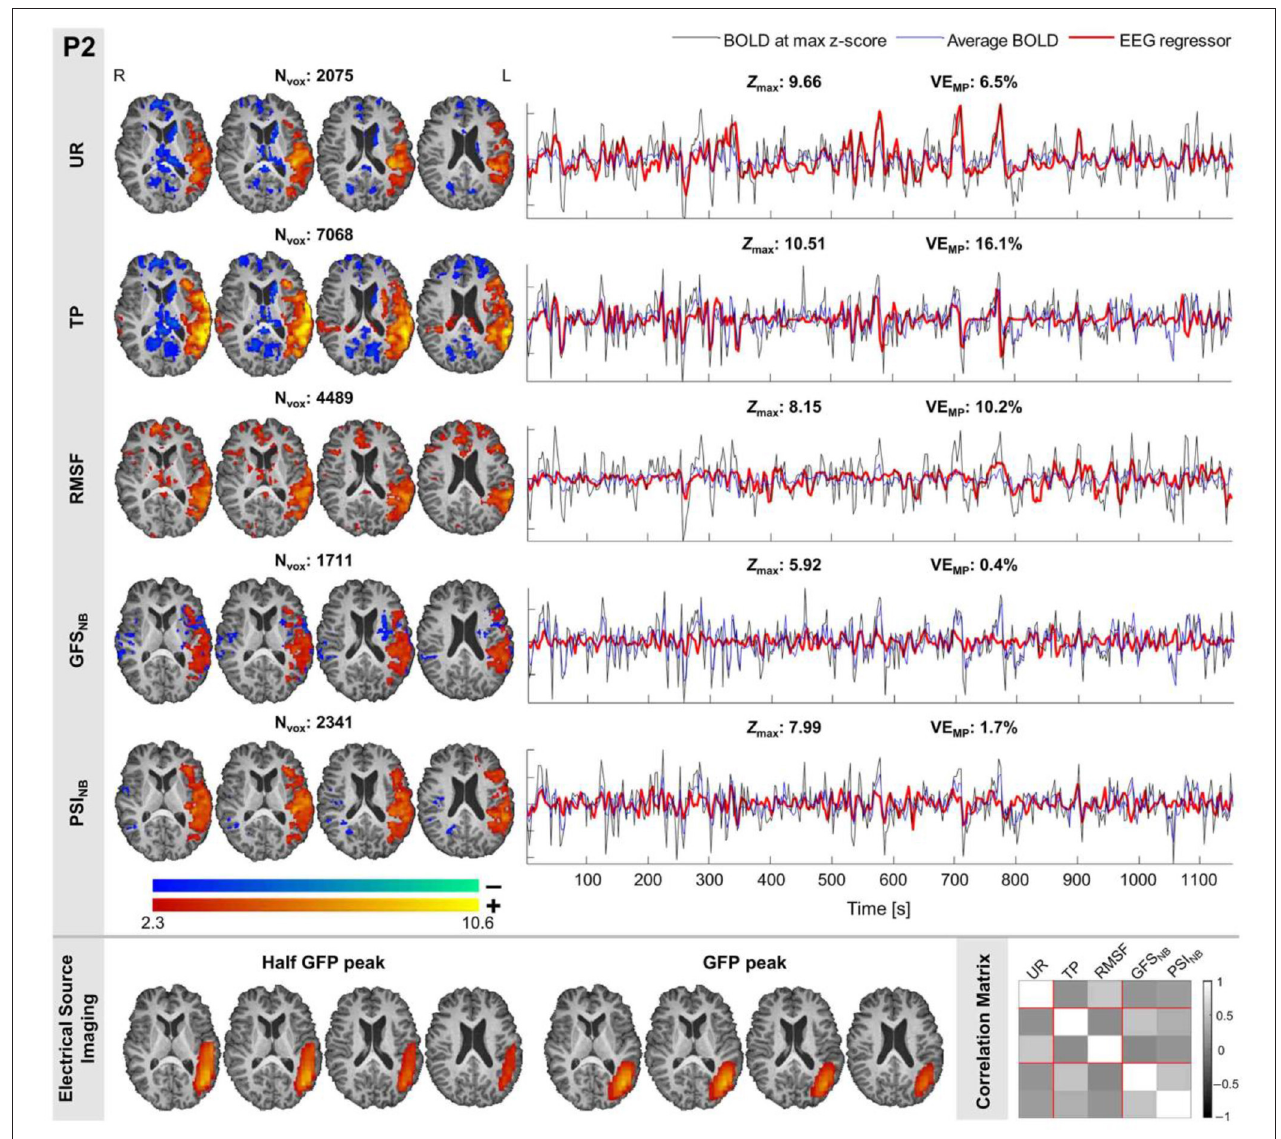
FIGURE 14 | The results of epileptic network mapping for a patient. (Top–Left) The epileptic networks obtained using the EEG regressors UR, TP, RMSF, GSF NB , and PSI NB , together with the number of voxels (Nvox); the color codes red-yellow and blue-green depict positive and negative BOLD responses, respectively. (Top–Right) The BOLD signal measured at the maximum Z-score voxel (black trace), the average BOLD signal within the activation cluster (blue trace), and EEG regressor (thicker red trace), together with the maximum Z-score (Zmax) and the variance explained by the motion parameters (VEMP). (Bottom–Left) ESI solution maps at IED onset and propagation, obtained at half the maximum of the first rising phase of GFP and its associated peak, respectively, for validation of the GLM-derived epileptic networks. Consistent results with the ESI solutions were obtained for all patients with clear IEDs only when using the PSI NB metric. (Bottom–Right) Correlation matrix between all metrics of interest